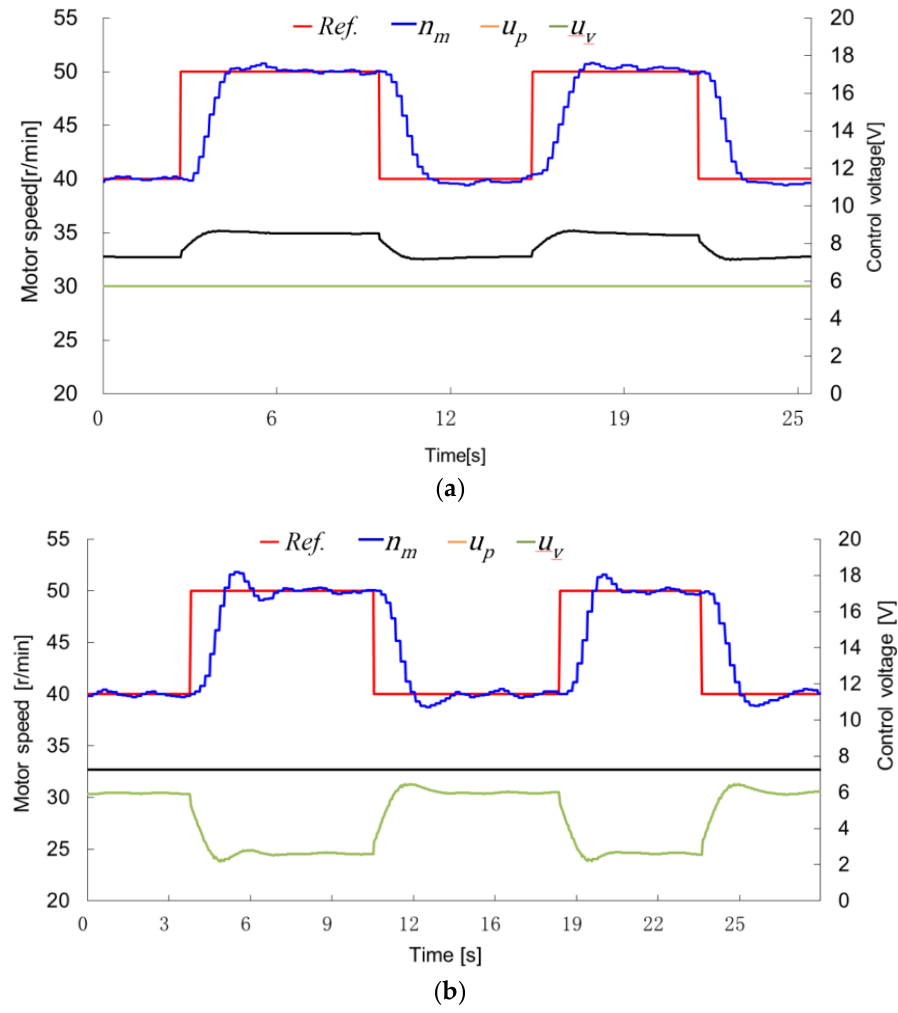
Figure 6. Step response of pump control and valve control. ( a ) Pump control circuit; ( b ) Valve control circuit. Table 2. Coefficients of PI under different